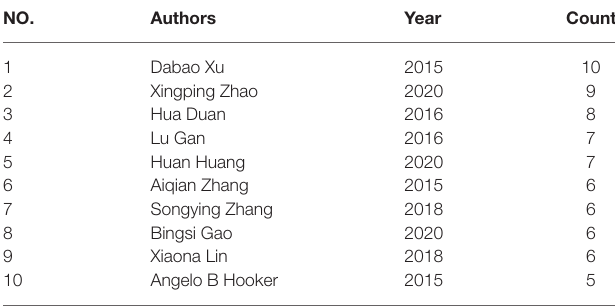
Frontiers in Reproductive Health |